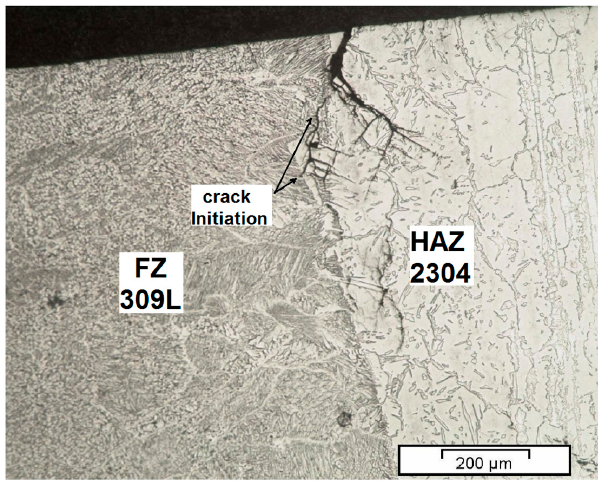
Figure 9. Microstructure showing the presence of cracks in fusion zone of 309L weld metal and in HAZ of the 2304 DSS.